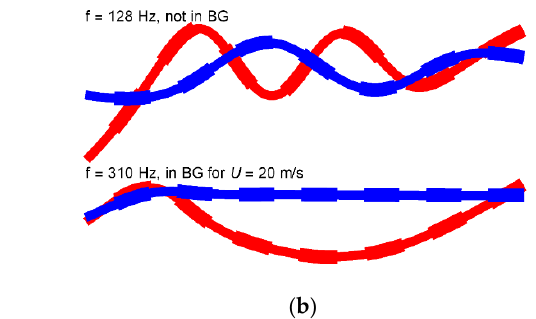
Figure 8. Vibration attenuation shapes of a representative fluid-conveying periodic pipe with 7 cells in different BG regions: ( a ) BG1, ( b ) BG2. (the thick and thin curves denote the two segments of a cell.) Blue— U = 20 m/s, Red—without fluid loading.